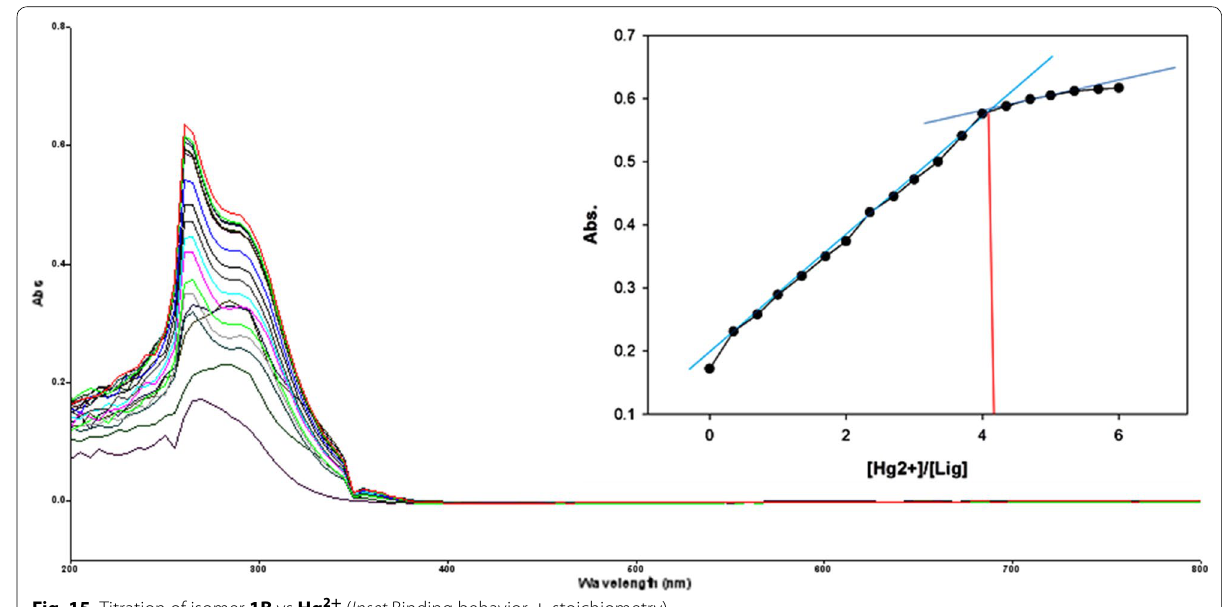
Fig. 15 Titration of isomer 1B vs Hg 2 + ( Inset Binding behavior